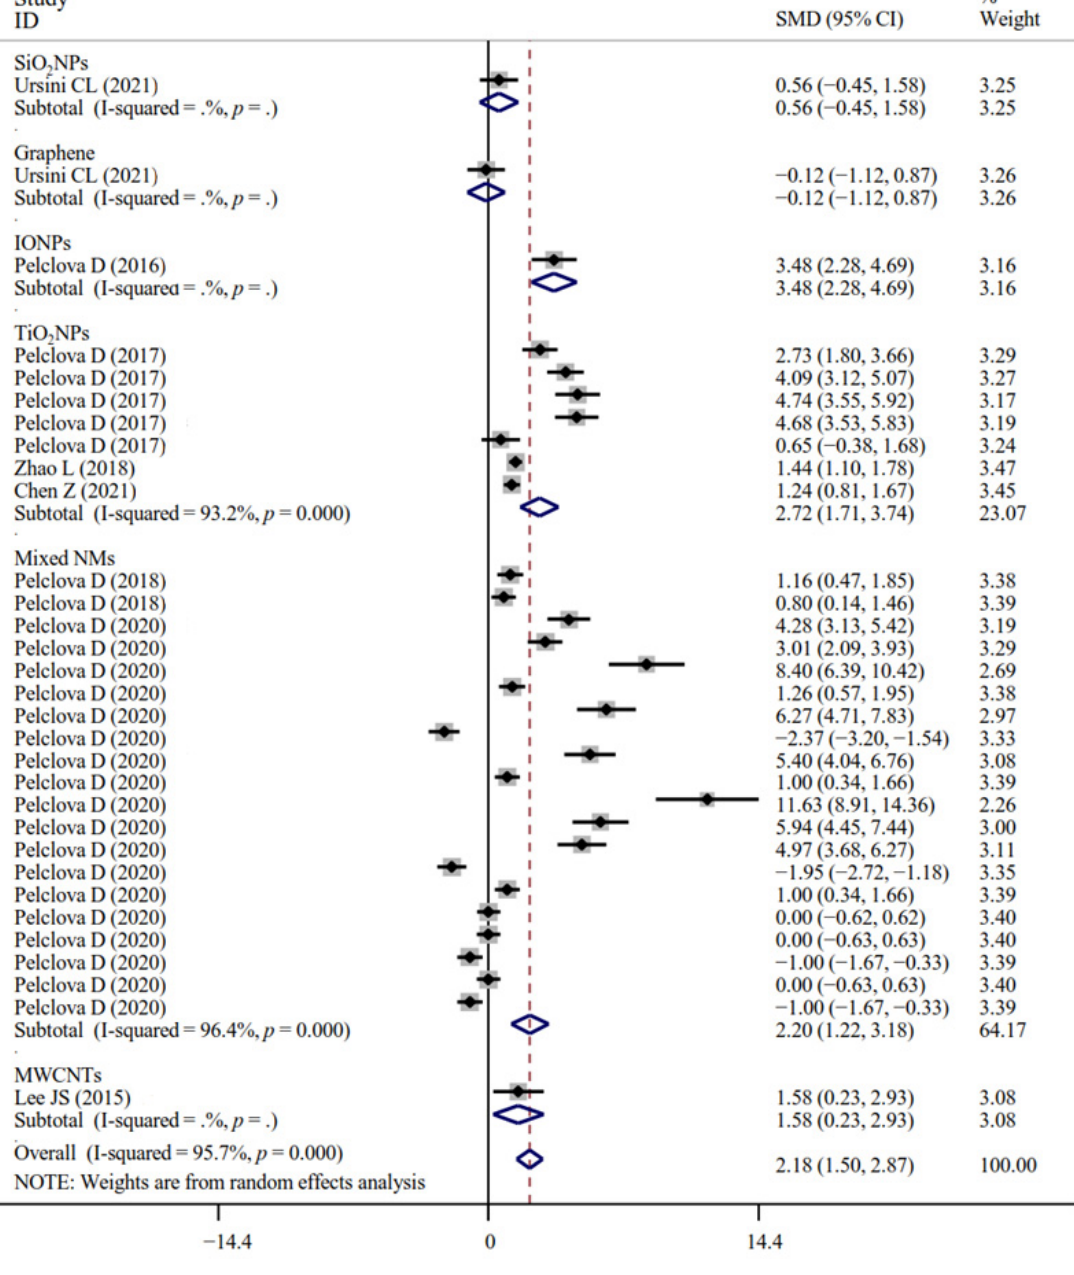
Figure 2. Forest plots assessing the effects of exposure to different NMs on the level of MDA compared with the non-exposed control group. NMs, nanomaterials; SiO 2 NPs, silica oxide nanoparticles; IONPs, iron oxide nanoparticles; TiO 2 NPs, titanium dioxide nanoparticles; MWCNTs, multi-walled carbon nanotubes; MDA, malonaldehyde; SMD, standardized mean difference; CI, confidence interval [15,18,19,31,33,34,43,45].